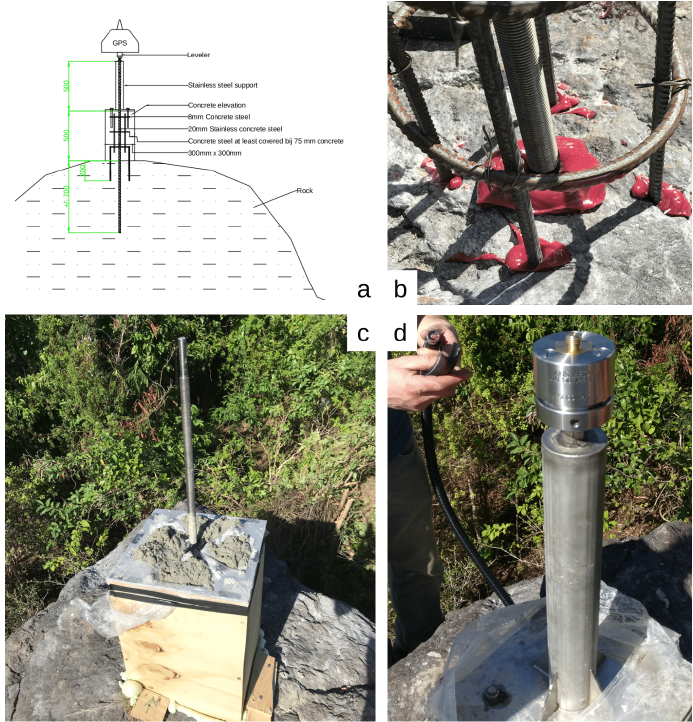
Figure 11. ( a ) Sketch of the monument design (J-W Schoonderwoerd, 2018); ( b ) A one